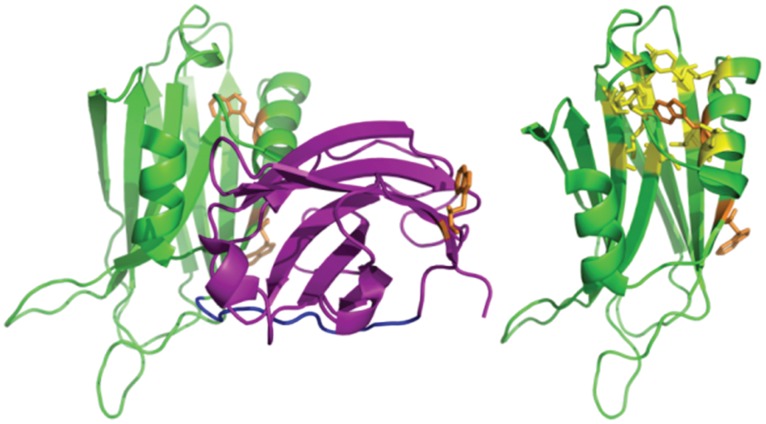
Location of tryptophan residues (orange) in C2A (purple) and C2B (green).Two of three tryptophan residues (C2A’s and one of C2B’s) occupy superficial positions and may, as a result, be more solvent exposed in solution (left). The second tryptophan in the C2B domain is partially embedded in the core of the β-sandwich motif amongst several hydrophobic residues (yellow) (right). The differences in tryptophan environment likely give rise to unequal FLT signal contributions, with most of the signal coming from C2B’s β-sandwich residue.